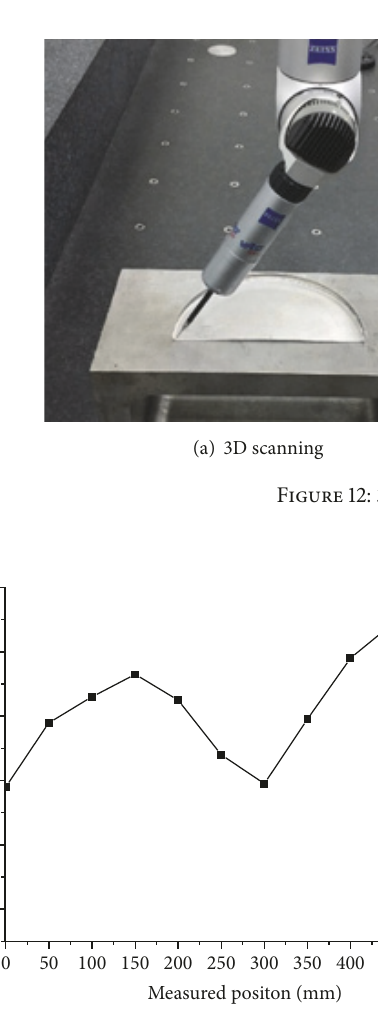
Figure 13: Radius of curvature on sharp